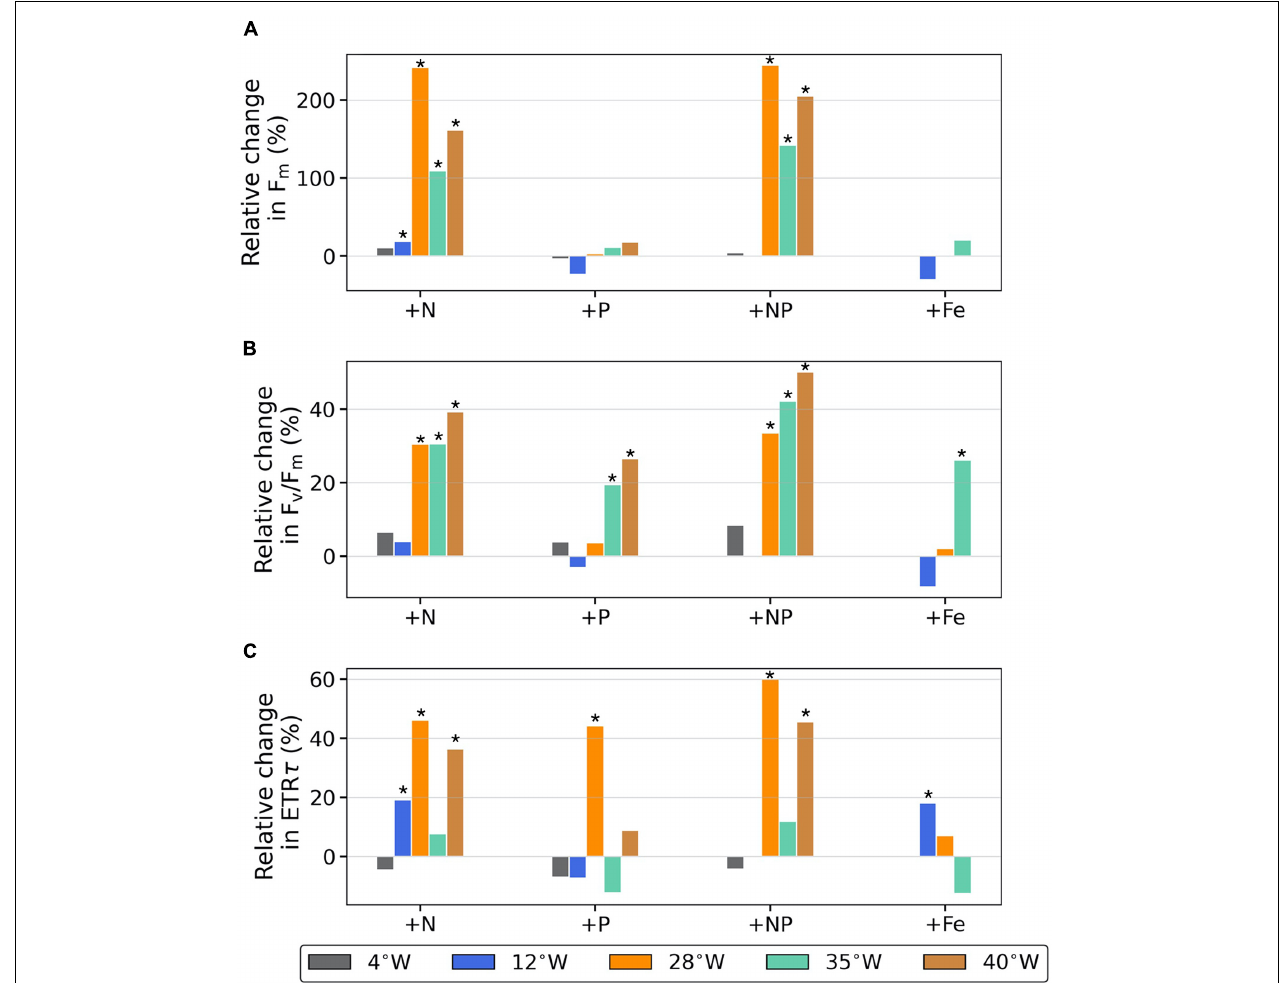
FIGURE 6 | Relative changes in photophysiology 24 h after nutrient amendment. (A) F m , (B) F v /F m , and (C) ETR τ . Treatments included amendment with, nitrate (+N), phosphate (+P), nitrate and phosphate combined (+NP) and iron (+Fe). Each bar color indicates location where NAE was initiated. Change was calculated as Tretment 24h − Control 24h for each parameter. Note the NAE at 4 ◦ W (gray bars) didn’t include a + Fe treatment, and the NAE 12 ◦ W (blue bars) didn’t include a + NP Control 24h treatment. An * denotes a statistically significant increase in the mean of the treatment compared to the